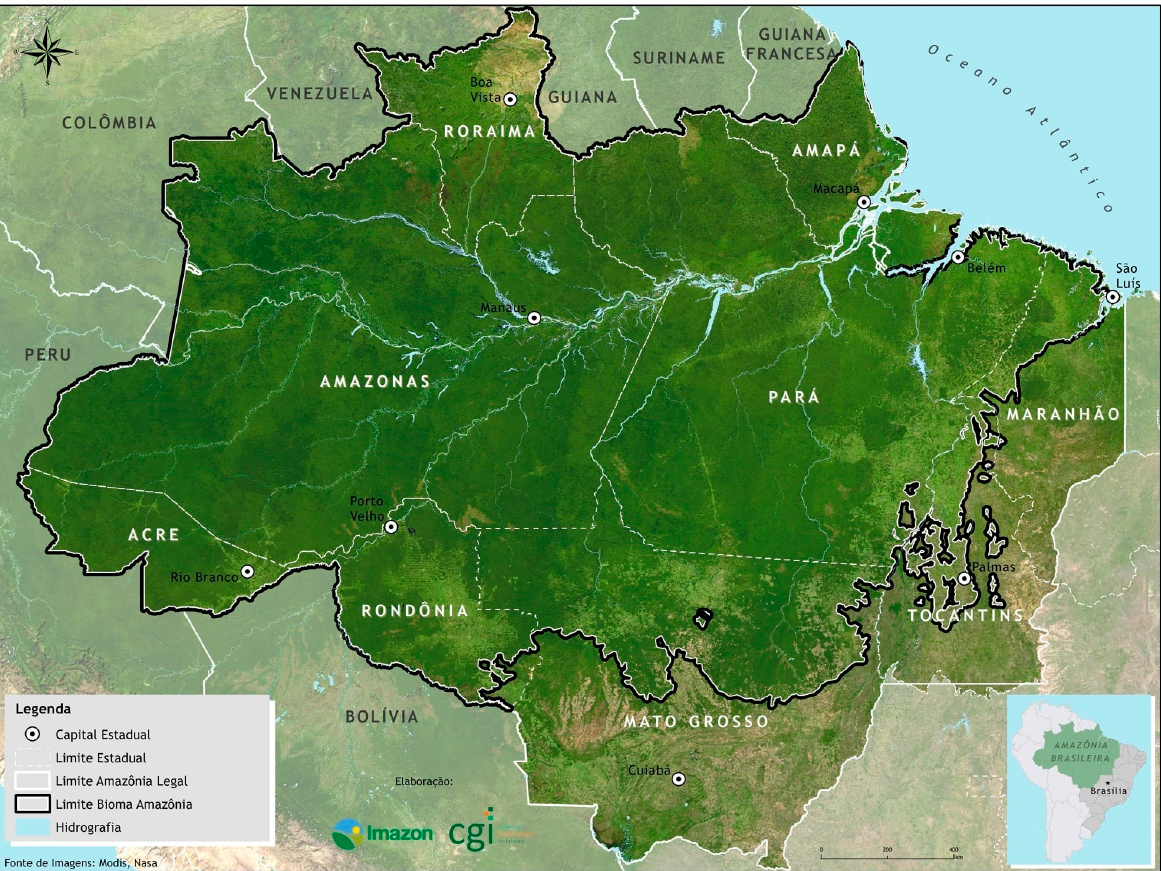
Figure 3. Brazilian Amazon map. Source: